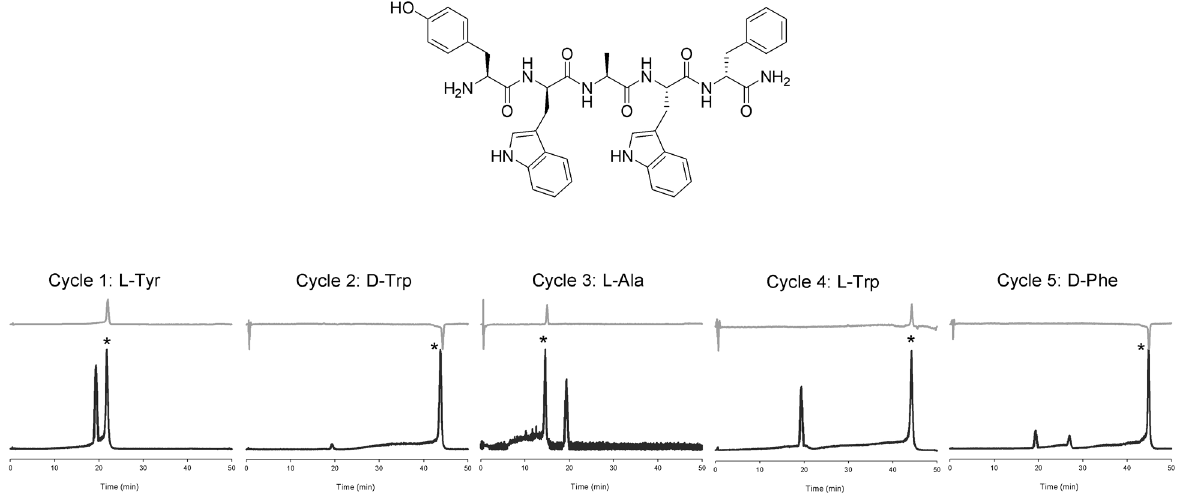
Figure 2. Ion chromatogram (dark) and CD absorption chromatogram (light) of the sequential Edman degradation products (asterisked) of a commercial pentapeptide. The unit of CD absorption is